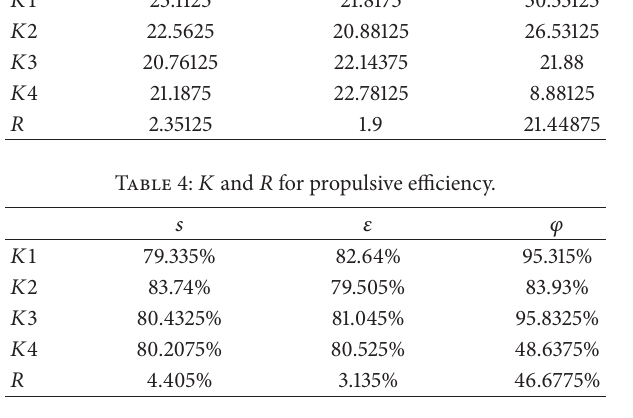
Table 5: 𝐾 and 𝑅 for propulsive force and propulsive efficiency.